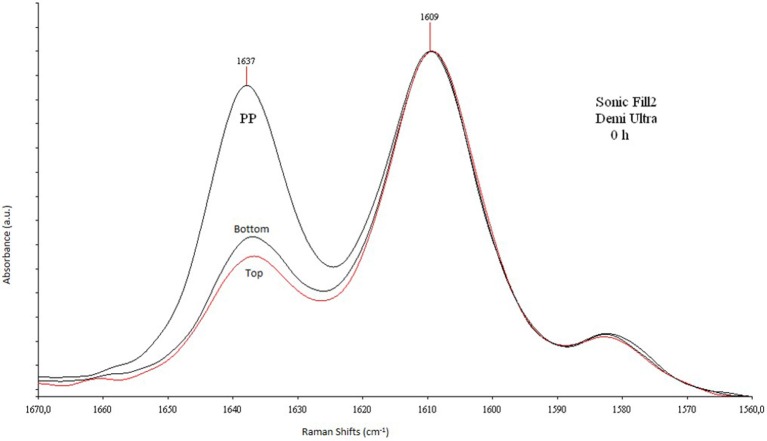
Raman spectra between the reaction and reference bands. Raman spectra in the region 1670–1560 cm−1 of SonicFill2, 4 mm-thick, cured with Demi Ultra.